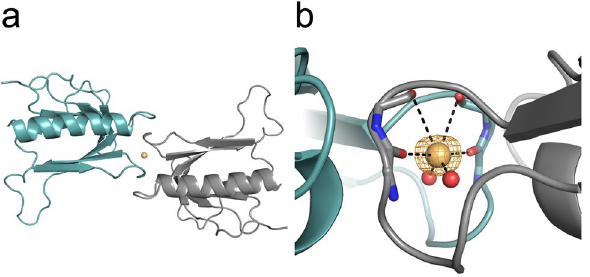
Figure 10. Cesium site 1 in p62 PH occupies a special position. ( a ) Cartoon representation of two p62 PH molecules related by a crystallographic two-fold axis perpendicular to the paper plane. The cesium ion located on this axis is represented as a sphere. ( b ) Detailed view of cesium site 1. The orange mesh displays the anomalous density contoured at 3